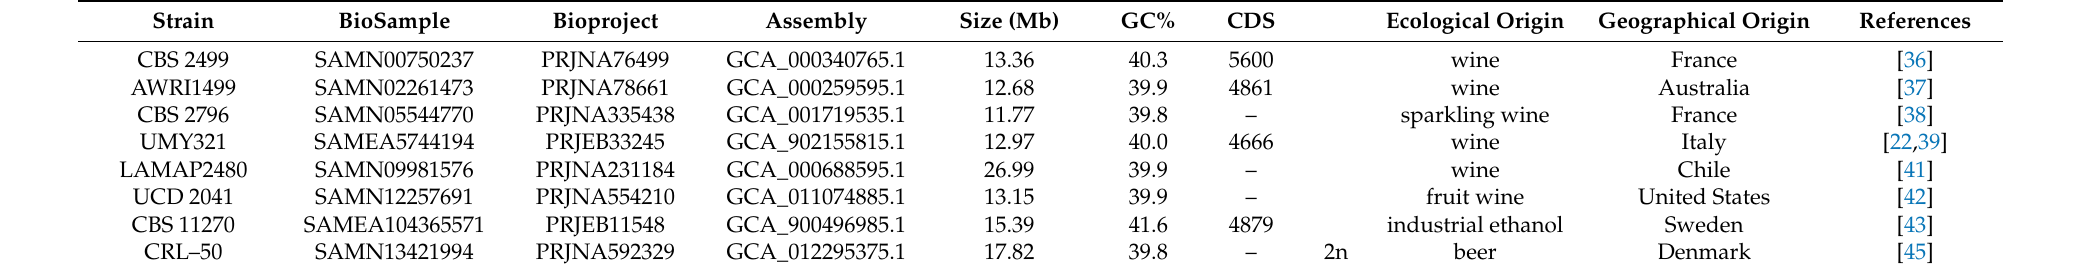
Table 2. Complete sequenced and deposited B. bruxellensis strain genomes and their characteristics.